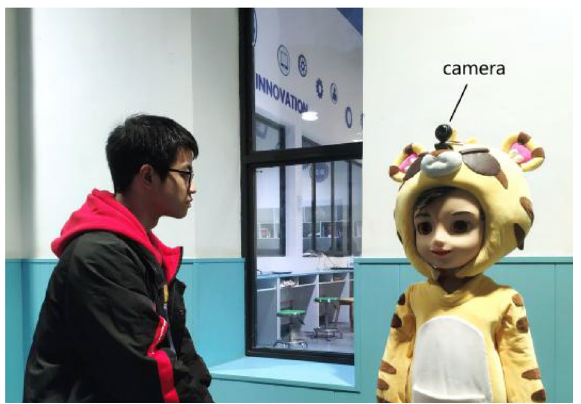
Figure 4. Participants were interacting with the social robot. The robot, wearing yellow clothes on the right, has a camera placed above its head to capture the interaction data of